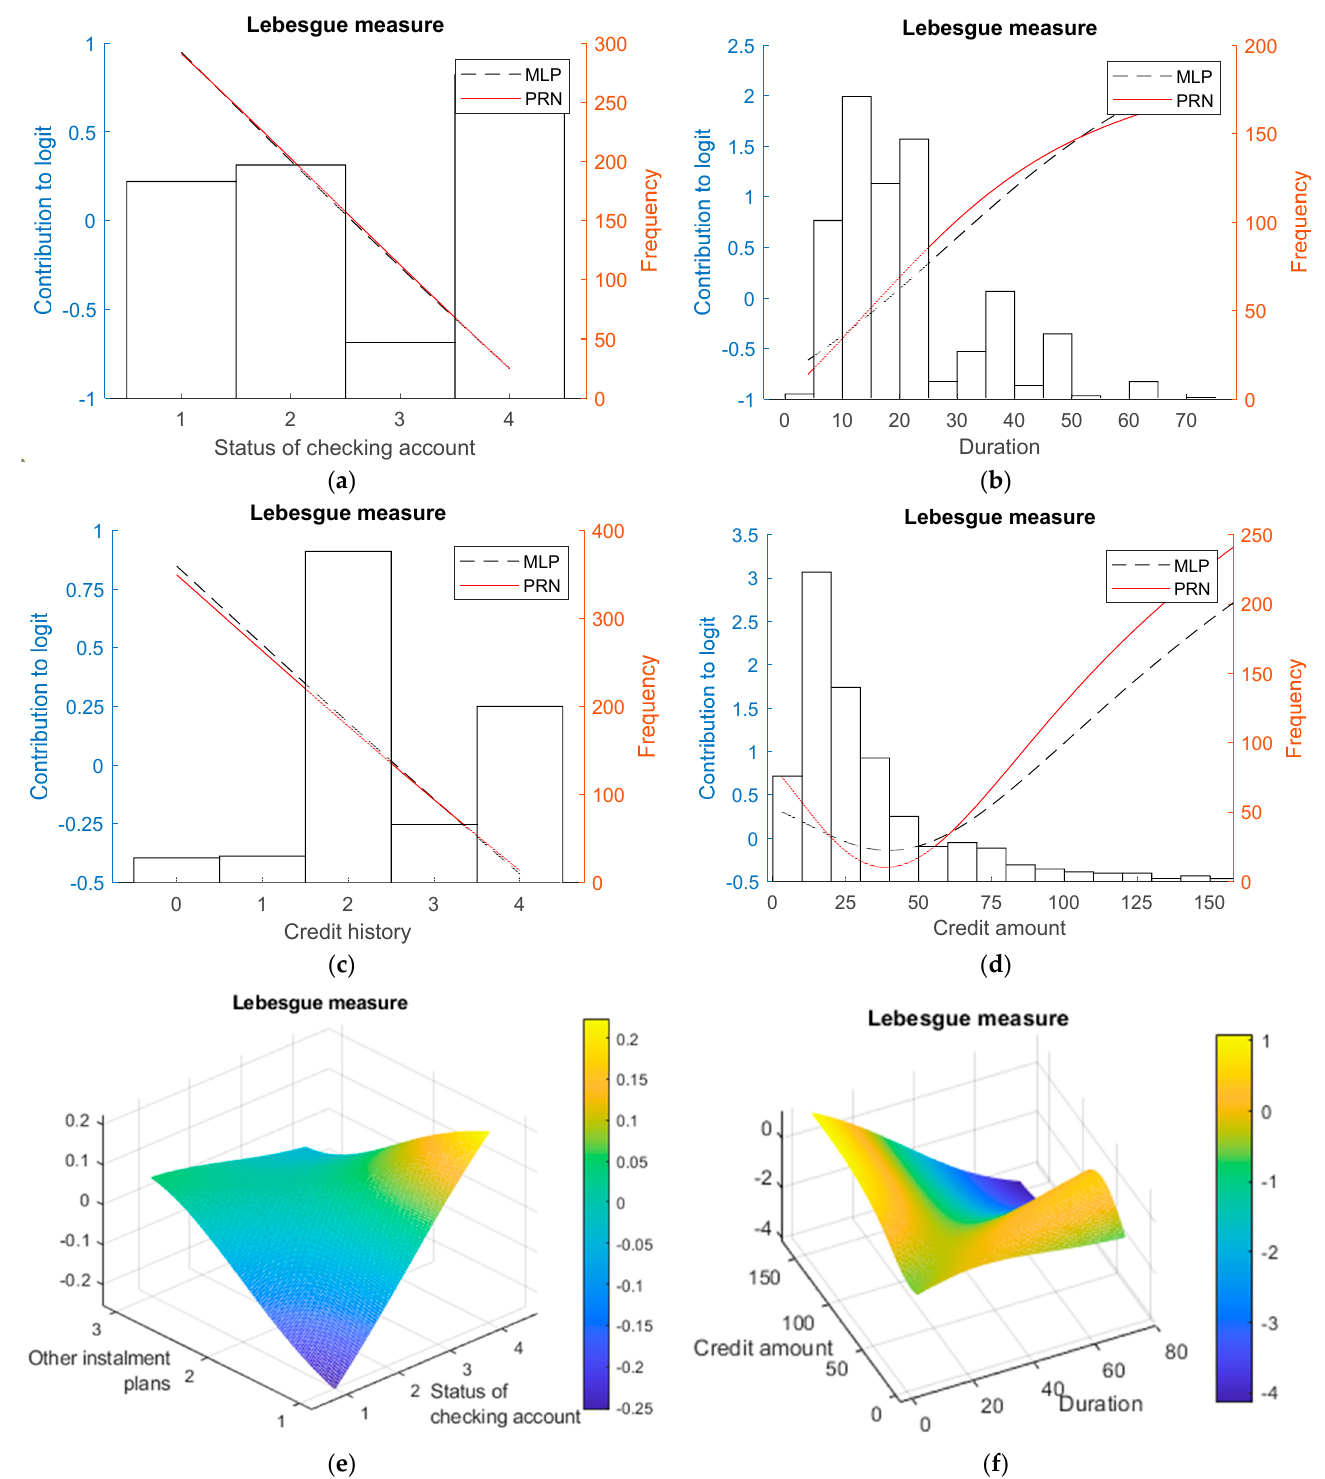
Figure 9. As for Figure 8, with the Lebesgue measure for the same covariates in ( a – d ), but with two pairwise interactions involving the variables listed in ( e , f ). Despite the different nature of the two measures, they offer entirely consistent interpretations, with the only difference being the selection by the Lasso model of a second bivariate interaction term, albeit with a range in contribution to the logit that is five times smaller than for the interaction term involving “Credit amount” and “Duration”.